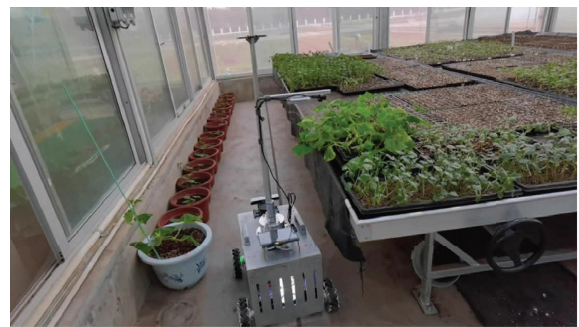
Figure 15: Photo of the robot test in the